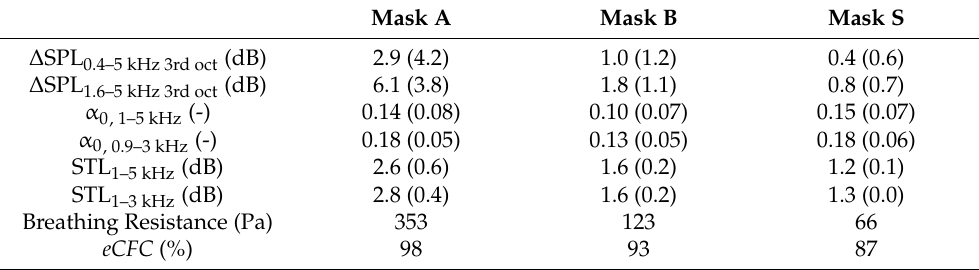
Table 2. Characterization of the masks in terms of sound attenuation ( ∆ SPL), sound absorption ( α 0 ), sound transmission loss (STL), breathing resistance, and filtration efficiency ( eCFC ). Standard deviations are given in the